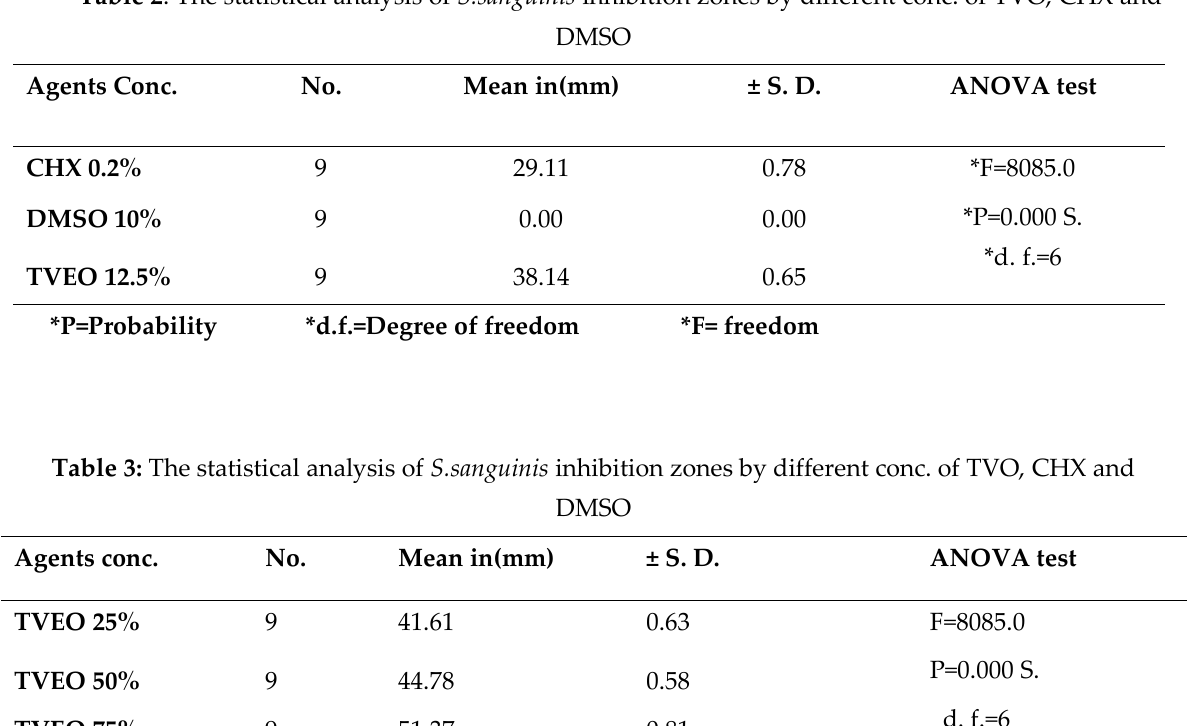
Table 2 : The statistical analysis of S.sanguinis inhibition zones by different conc. of TVO, CHX and DMSO Agents Conc. No. Mean in(mm)